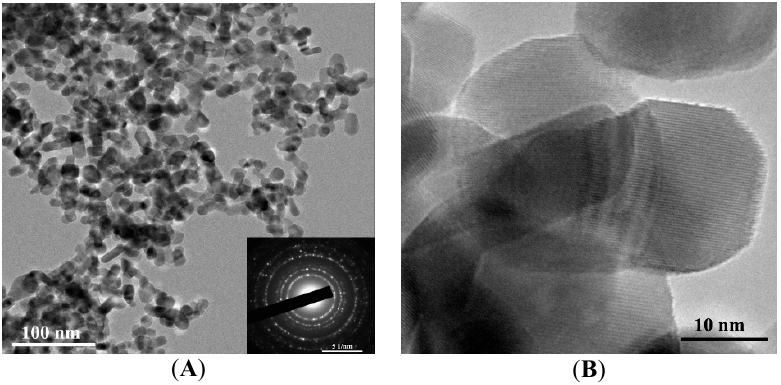
Figure 4. TEM images of the nanoparticles annealed at 610 °C at different magnifications ( A , B ); electron diffraction pattern (inset of figure ( A )).